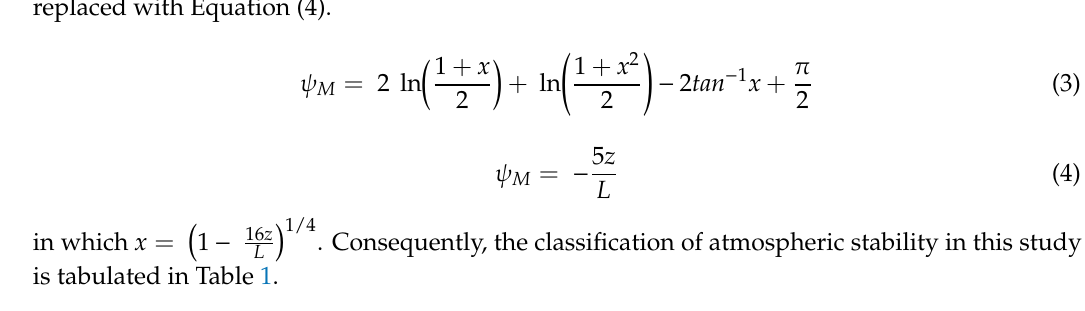
Table 1. Classification of atmospheric stability in this